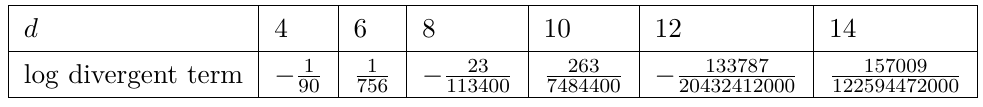
Table 1 . Log divergent term of the patition function of conformal scalar in even dimnsion. W ( b )